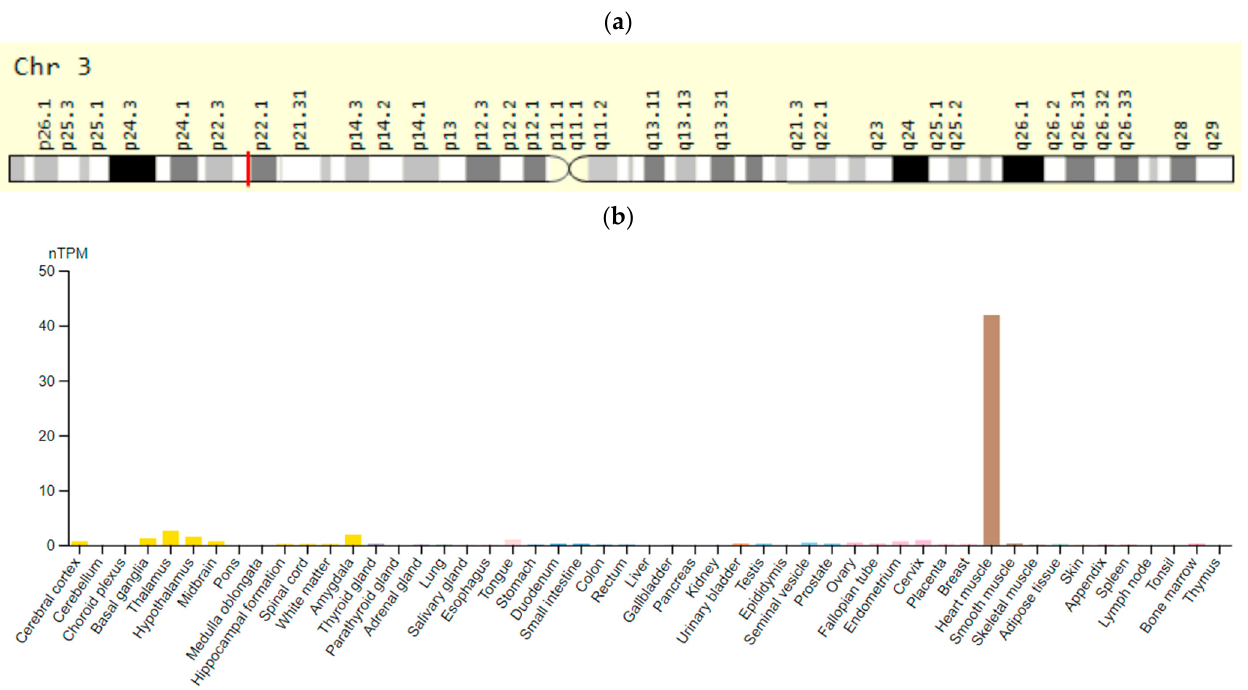
Figure 3. The SCN5A gene: ( a )—gene chromosome location; ( b )—protein expression in tissues of humans [55,56] .